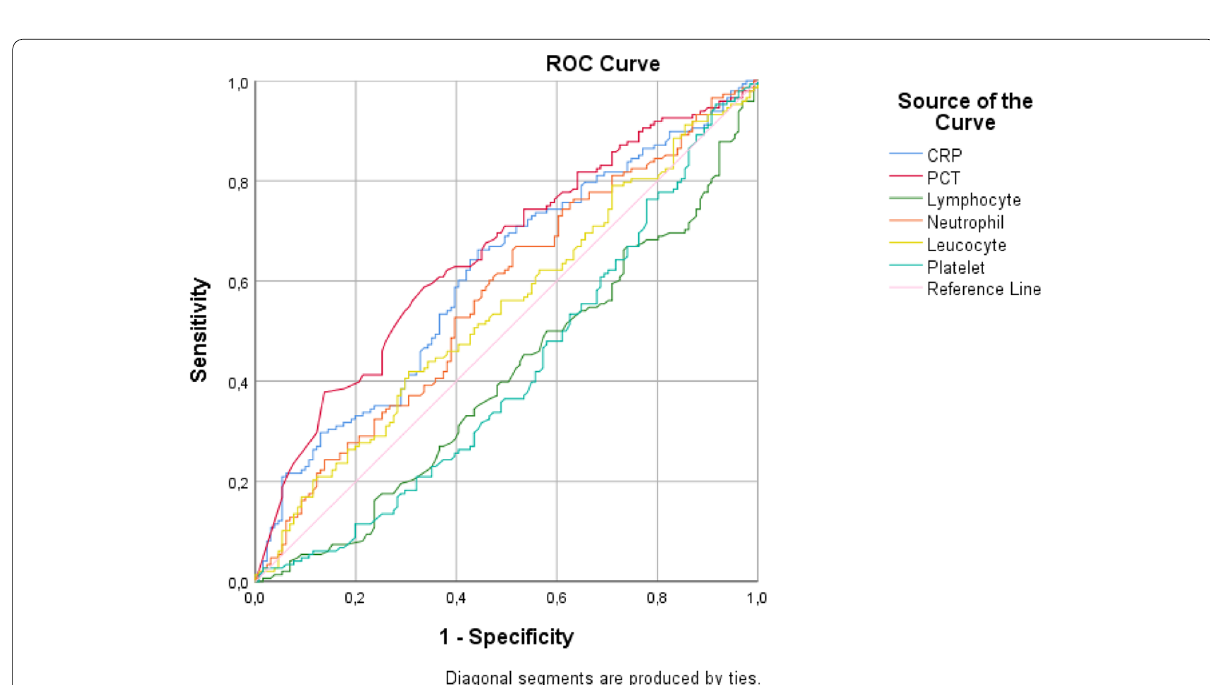
Fig. 2 AUC of ROC curve of the CRP, PCT, lymphocyte, neutrophil, leucocyte and platelet